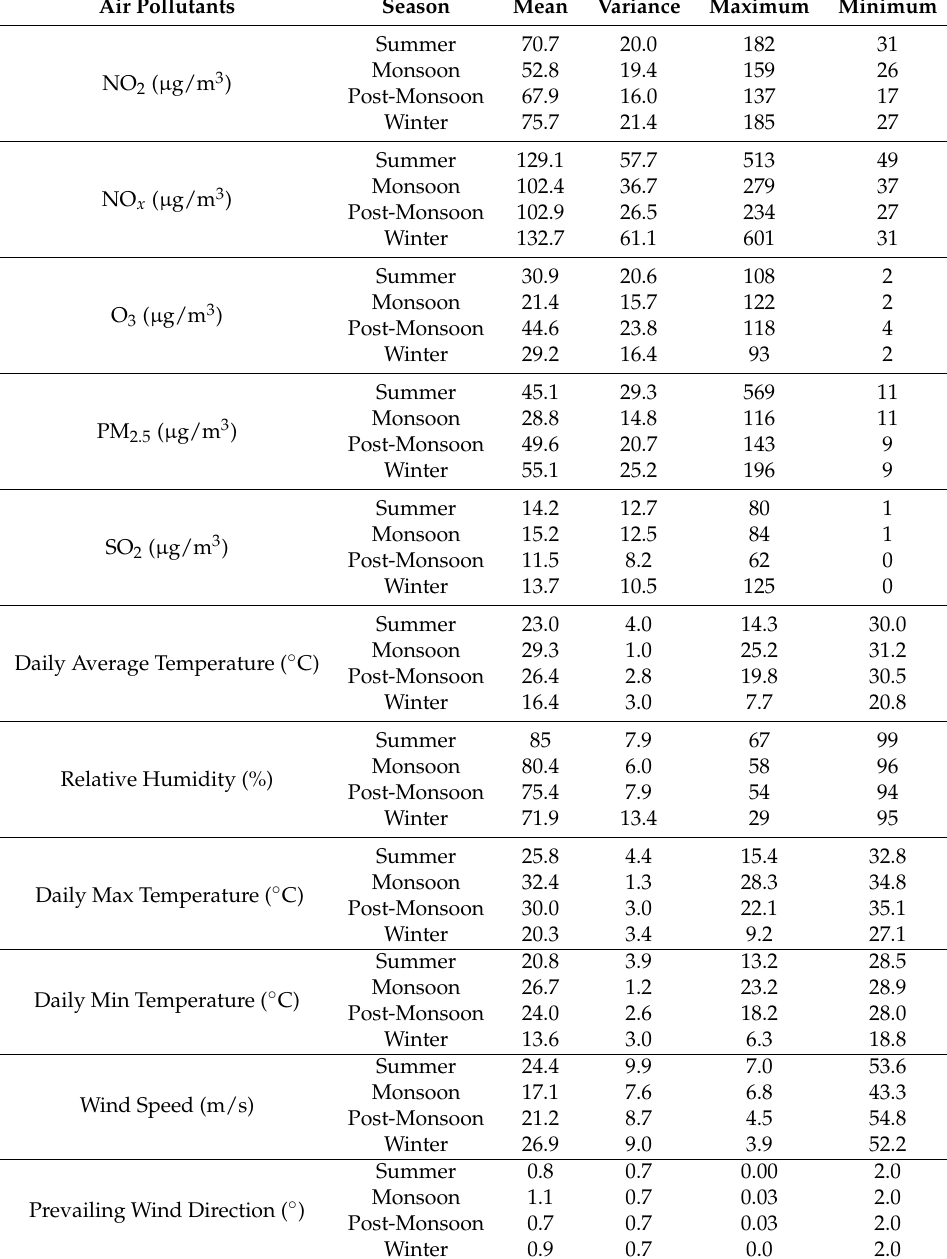
Table 1. The statistical description of four seasons in Sham Shui Po and Tap Mun, Hong Kong. Air